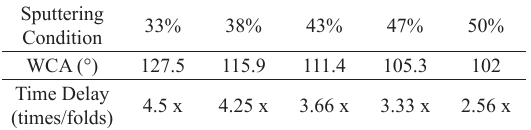
Table 2. Contact angle and anti-icing characteristics of prepared coatings. Sputtering Condition